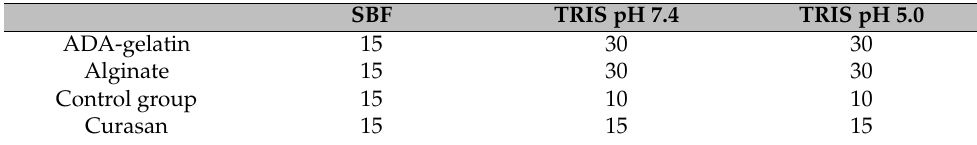
Table 2. Sample distribution of the β -TCP ceramics for the compression test.